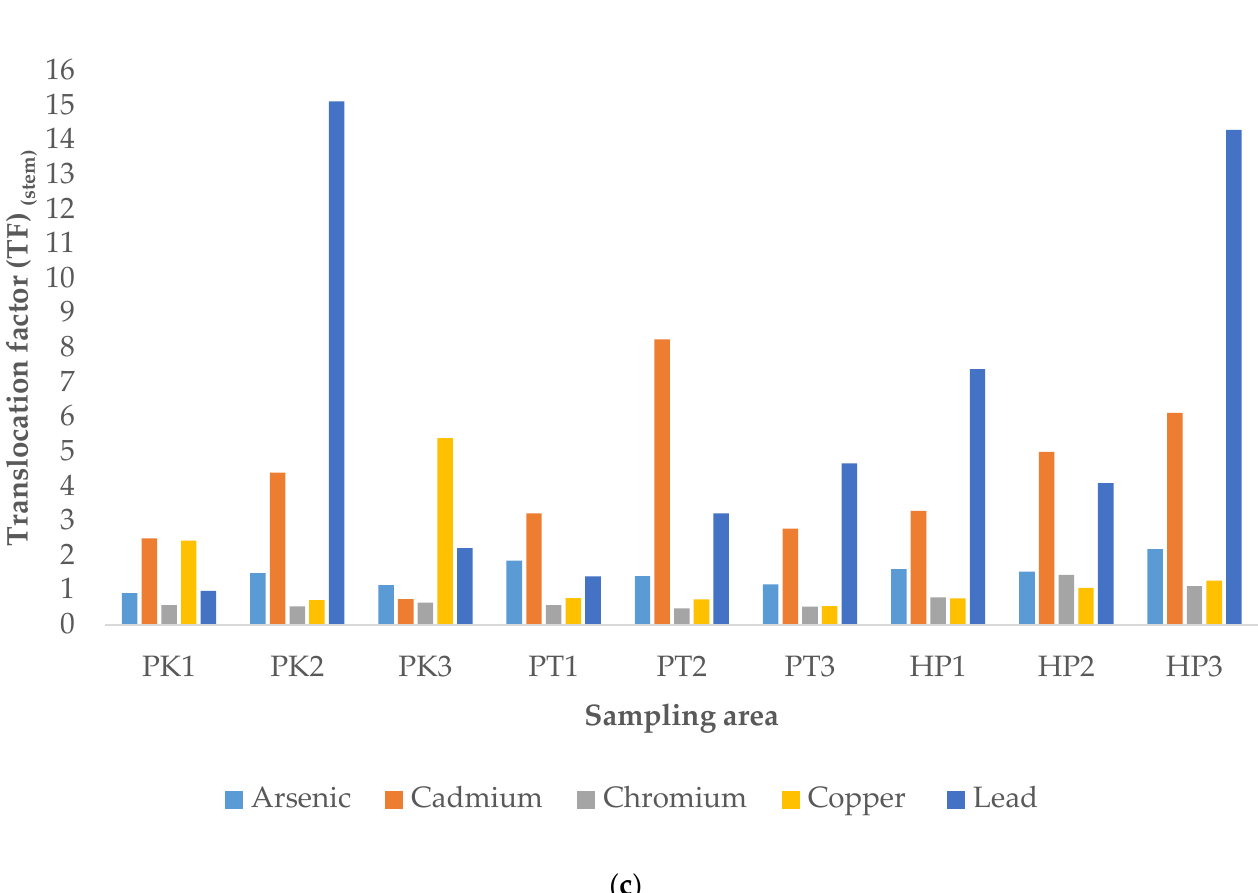
Figure 2. Translocation factor (TF) from soil to root (TFsoil, ( a )), root to stem (TFroot, ( b )) and stem to grain (TFstem, ( c )). P1K, Plot 1 Kerian; P2K, Plot 2 Kerian; P3K, Plot 3 Kerian; P1PT; Plot 1 Perak Tengah; P2PT, Plot 2 Perak Tengah; P3PT, Plot 3 Perak Tengah; P1HP, Plot 1 Hilir Perak; P2HP, Plot 2 Hilir Perak; P3HP, Plot 3 Hilir Perak.